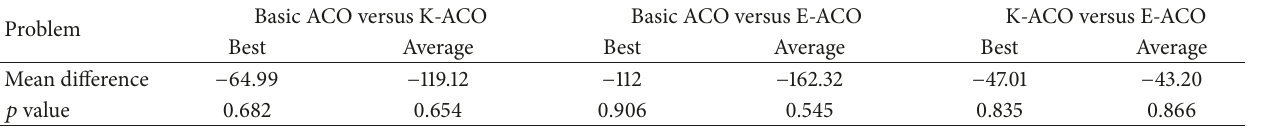
Table 6: 𝑡 -test significance results between each ACO.